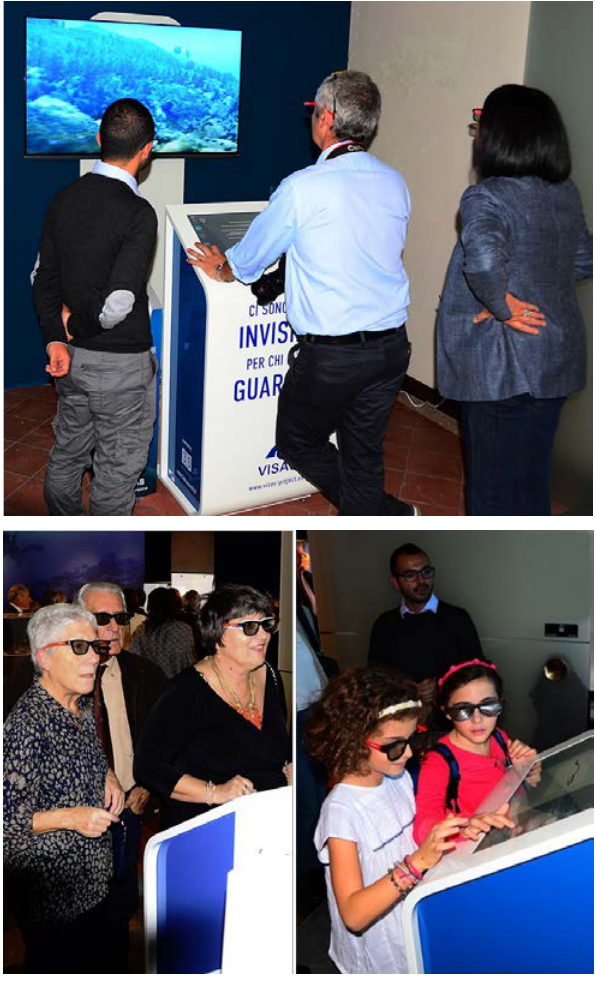
Figure 11. Visitors while experiencing the virtual diving in the underwater archaeological site of Cala